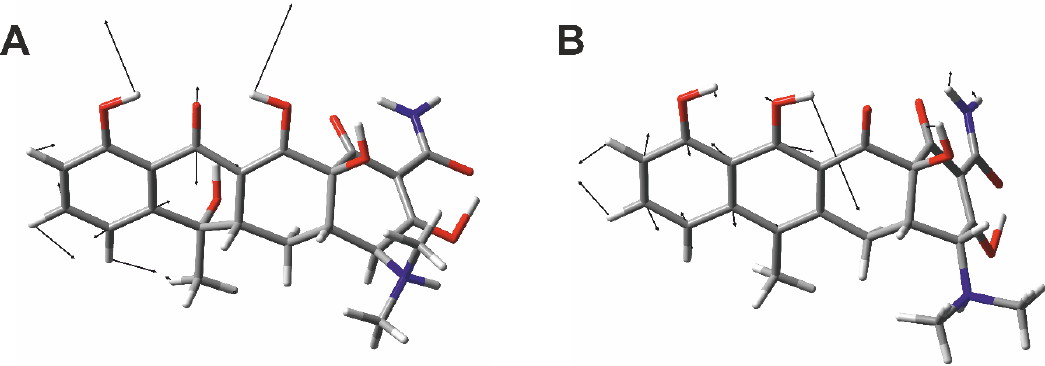
Figure 4. Assignment of the vibrational modes of the Raman marker bands. Atomic displacements of the Raman bands of TC at 1455 cm − 1 ( A ) and EATC at 1515 cm − 1 ( B ) is shown, respectively. The color code for the individual atoms is: hydrogen (white), carbon (grey), oxygen (red), and nitrogen (blue).